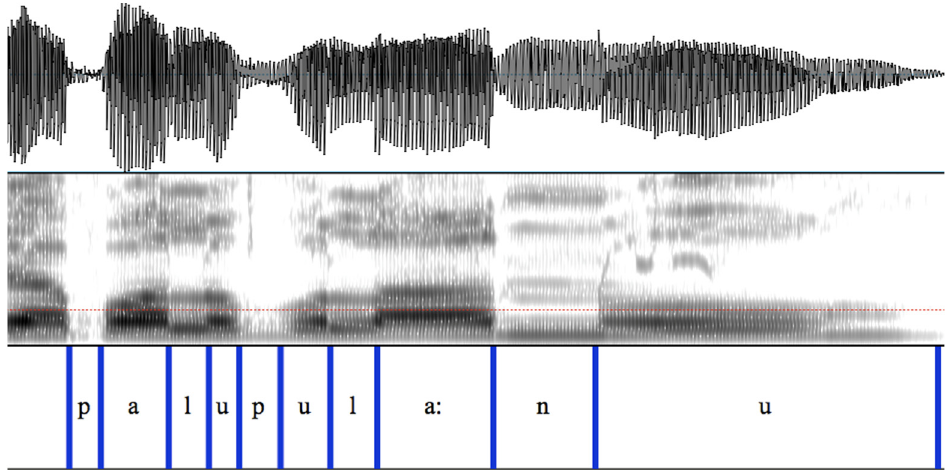
Figure 8. Example of a fully produced past tense suffix by Younger speaker DM (palu pula a-nu ‘3 SG 3 DU go- PST /the two of them went’). (SW20190411-05-LeafStory) This example also shows final lengthening of the /u/ vowel in the